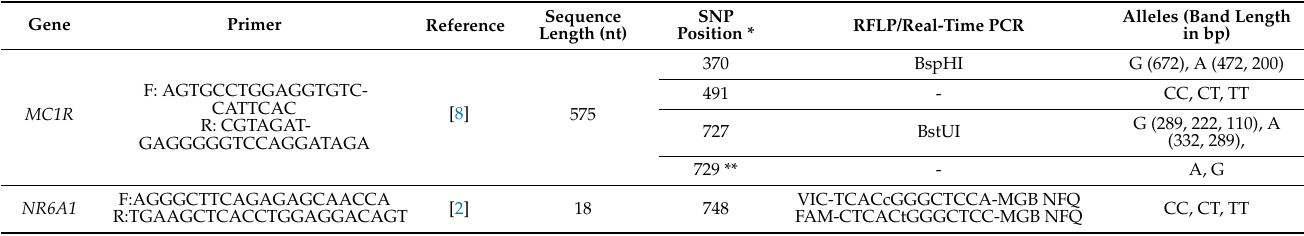
Table 1. Primer sequences used for amplification of MC1R and NR6A1 regions, Taqman probes used for real-time PCR, and restriction enzymes used for MC1R genotype